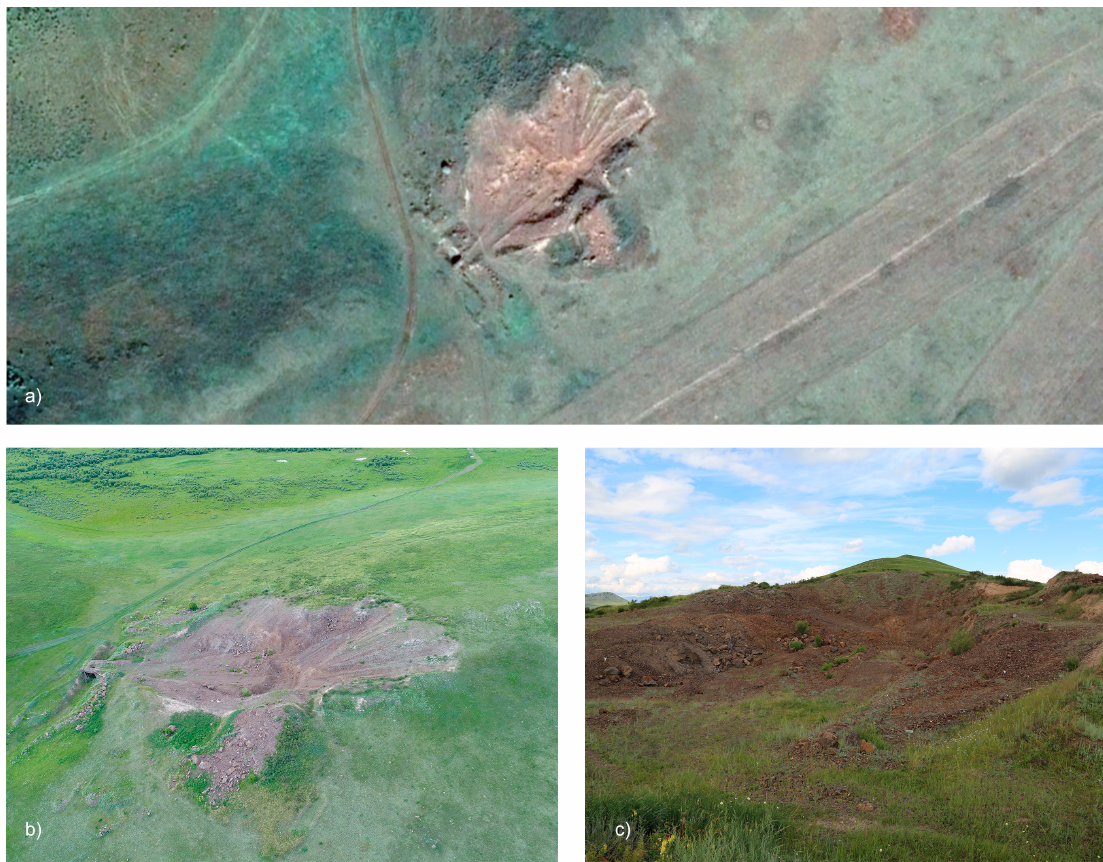
Figure 8. Example of a false positive detection of the Taygora quarry: ( a ) from high-resolution open-source optical satellite data (© CNES / Airbus 2019); ( b ) oblique drone shot; and ( c ) from the ground.